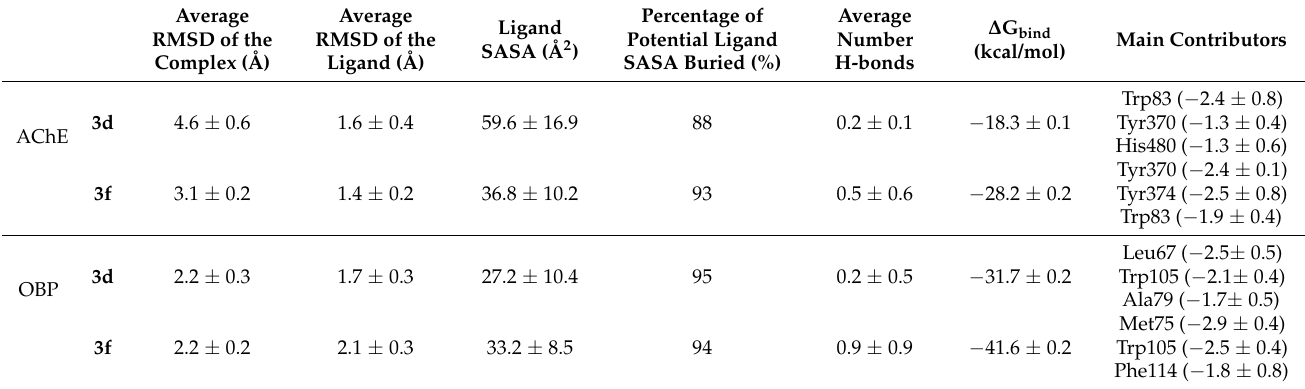
Table 2. Average protein and ligand RMSD values (Å), ligand RMSD (Å), average ligand SASA (Å), percentage of potential ligand SASA buried, and average number of ligand–target hydrogen bonds obtained from the MD simulations. ∆ G binding energy determined using MM/GBSA and per-residue decomposition, which were calculated for the last 90 ns of the